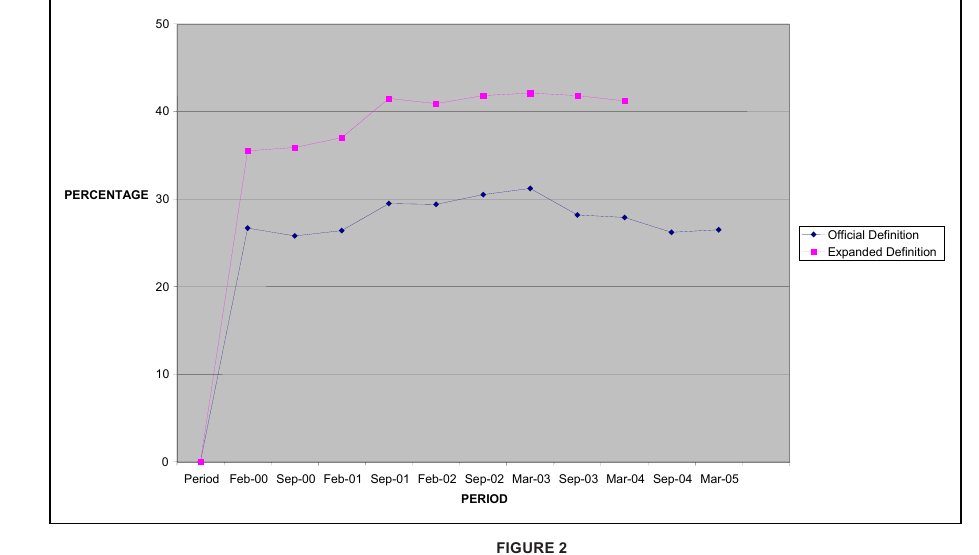
Figure 2 The comparison of employment figures as per the two